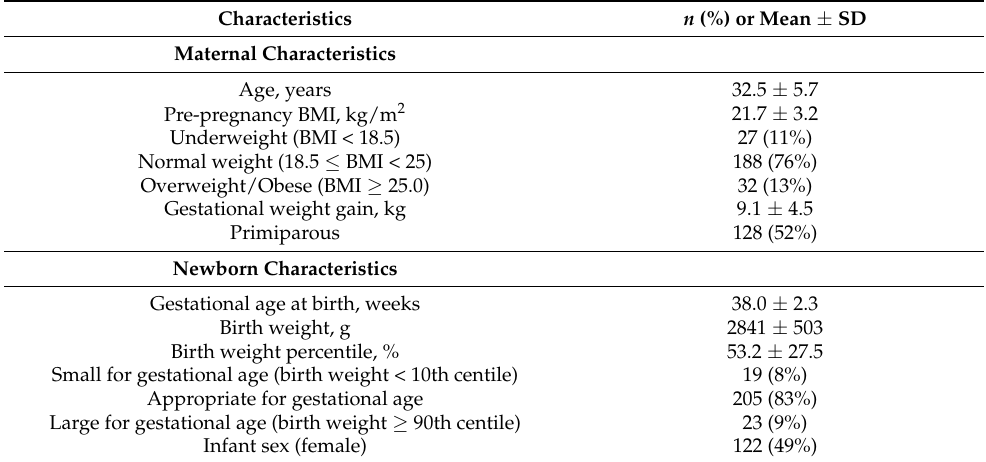
Table 1. Maternal and newborn demographic and clinical characteristics ( n =